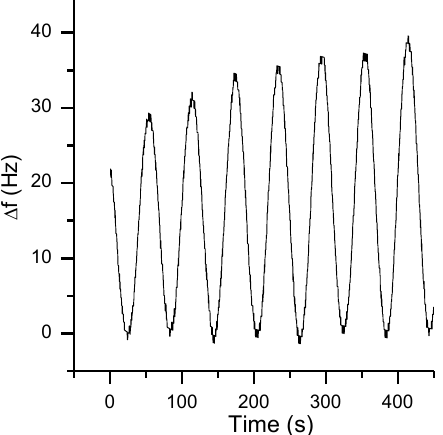
Figure 19. Frequency response of a rotation during the warm-up of the